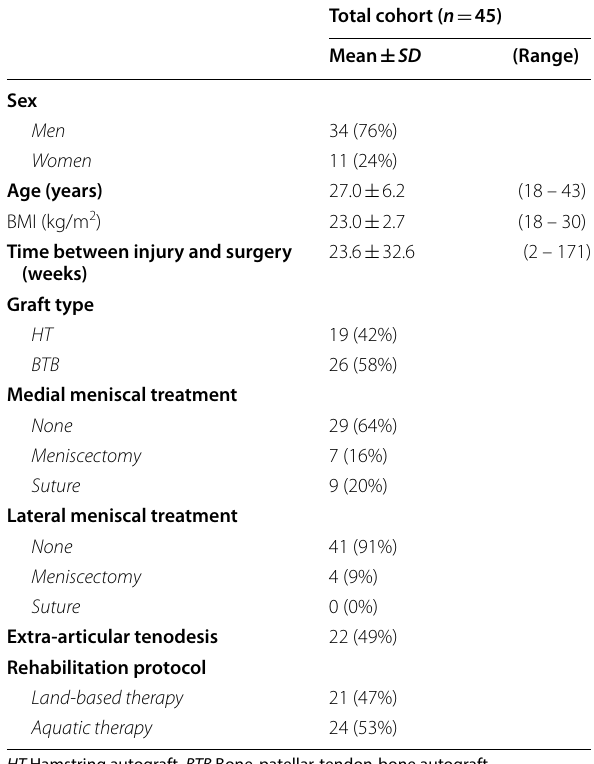
HT Hamstring autograft, BTB Bone-patellar-tendon-bone